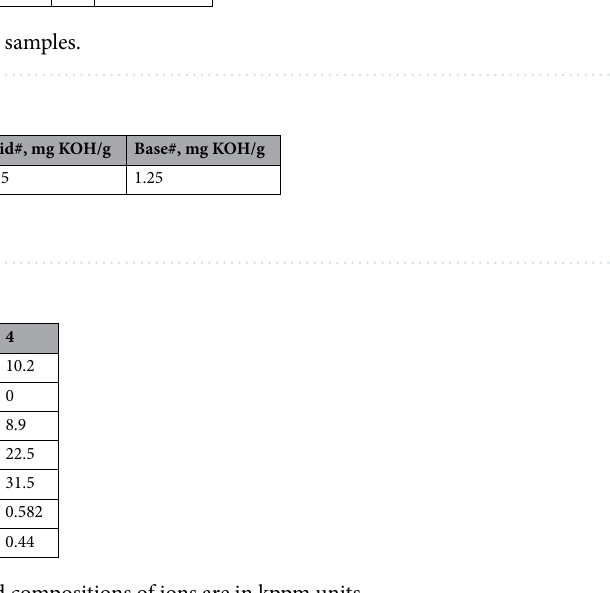
Table 4. Injected brine compositions and compositions of ions are in kppm